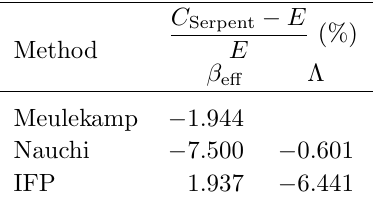
Table 20. Relative difference in Serpent-evaluated Flattop-23 kinetics